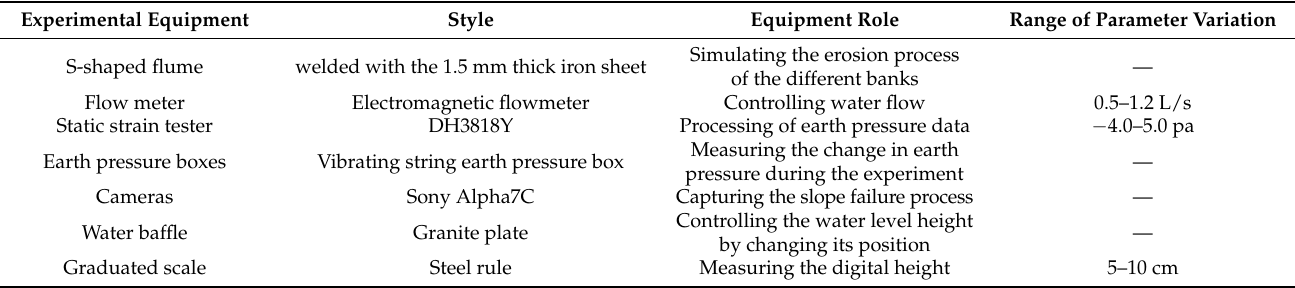
Table A2. Introduction of experiment